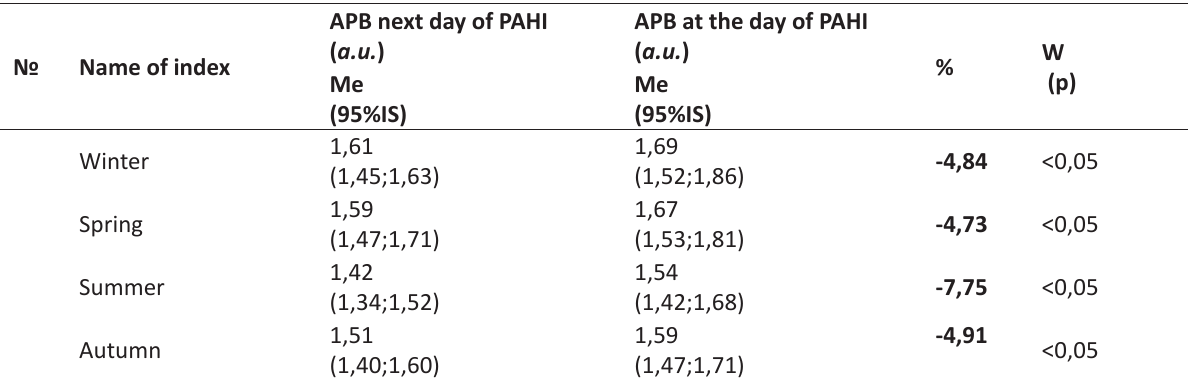
Table 6. Comparison of APB indices of the next day after PAHI with the indicators on the day of men’s employment, in seasonal periods